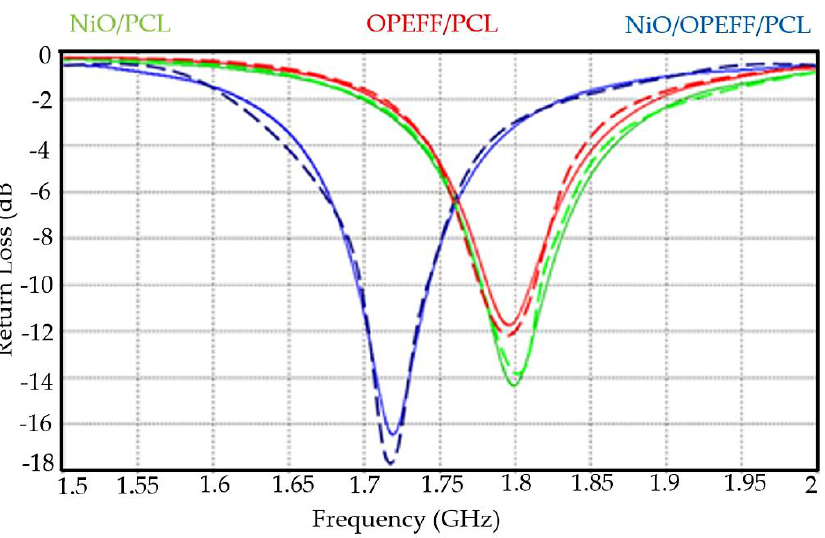
Figure 12. The return losses measurement and simulations results of the three microstrip antennas based on the different fabricated substrates.